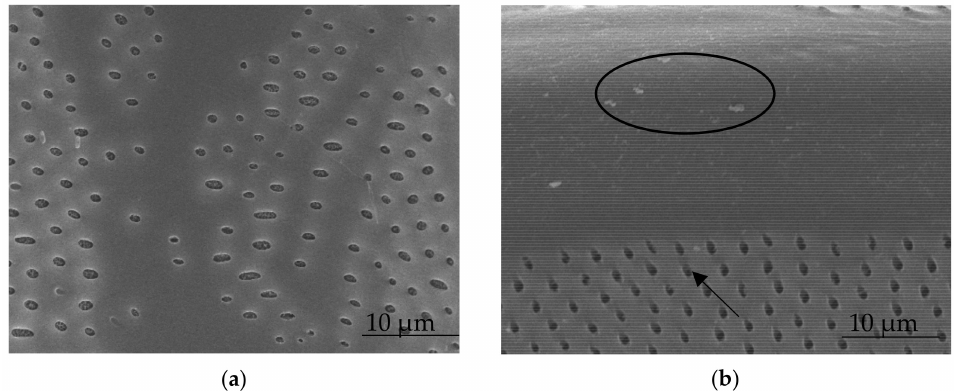
Figure 1. Morphology of wood ( a ) sengon MEG and ( b ) sengon MNano-Silica